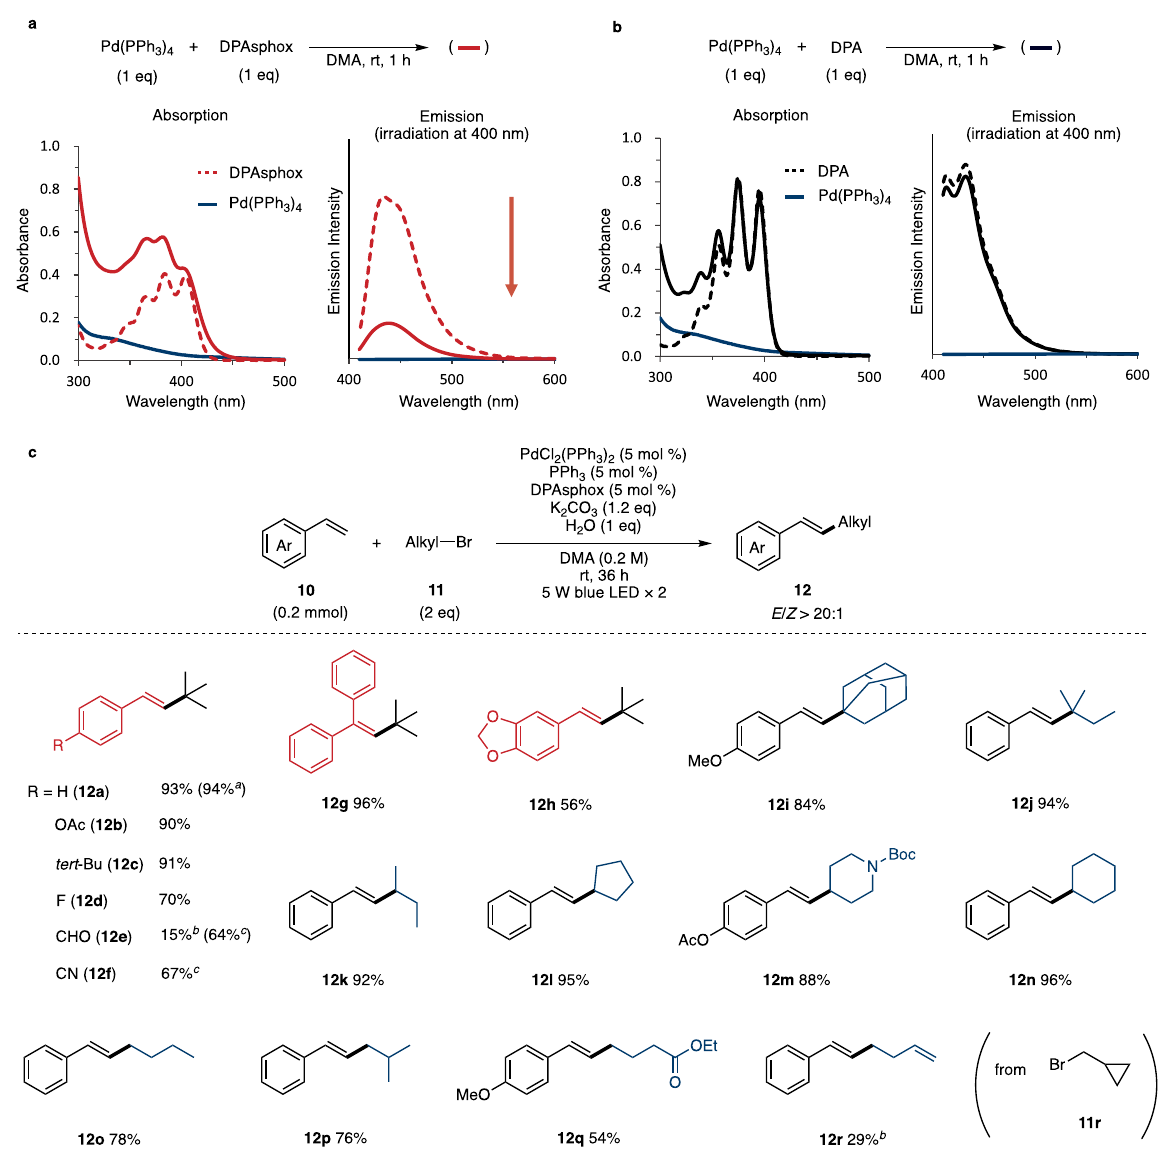
Fig. 4 Pd-catalyzed Heck reaction of unactivated alkyl bromide. a UV-Vis analysis with DPAsphox in DMA (0.05 mM). b UV-Vis analysis with DPA in DMA (0.05 mM). c Substrate scope. a 1.0 mmol scale. b Yield determined by 1 H NMR analysis. c P(OPh) 3 (5 mol %) was added. DMA N , N - dimethylacetamide, DPA